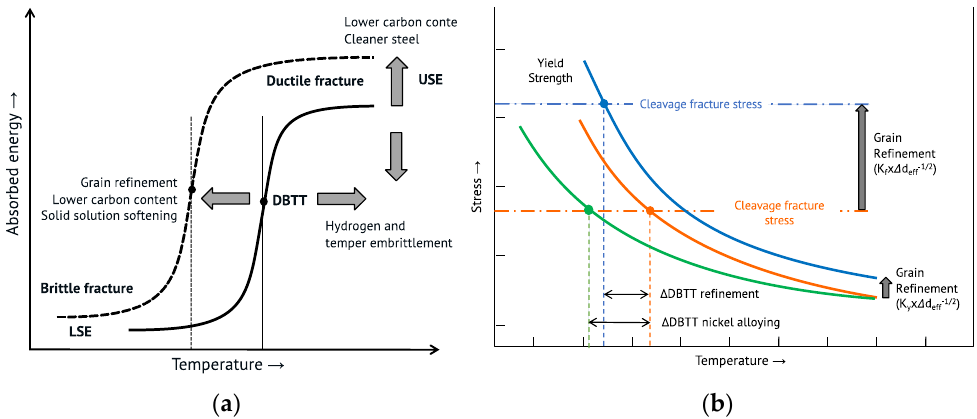
Figure 7. ( a ) Ductile ‐ to ‐ brittle transition behavior of bcc steel and influencing factors; ( b ) principles of lowering DBTT by grain refinement and solid solution softening (nickel